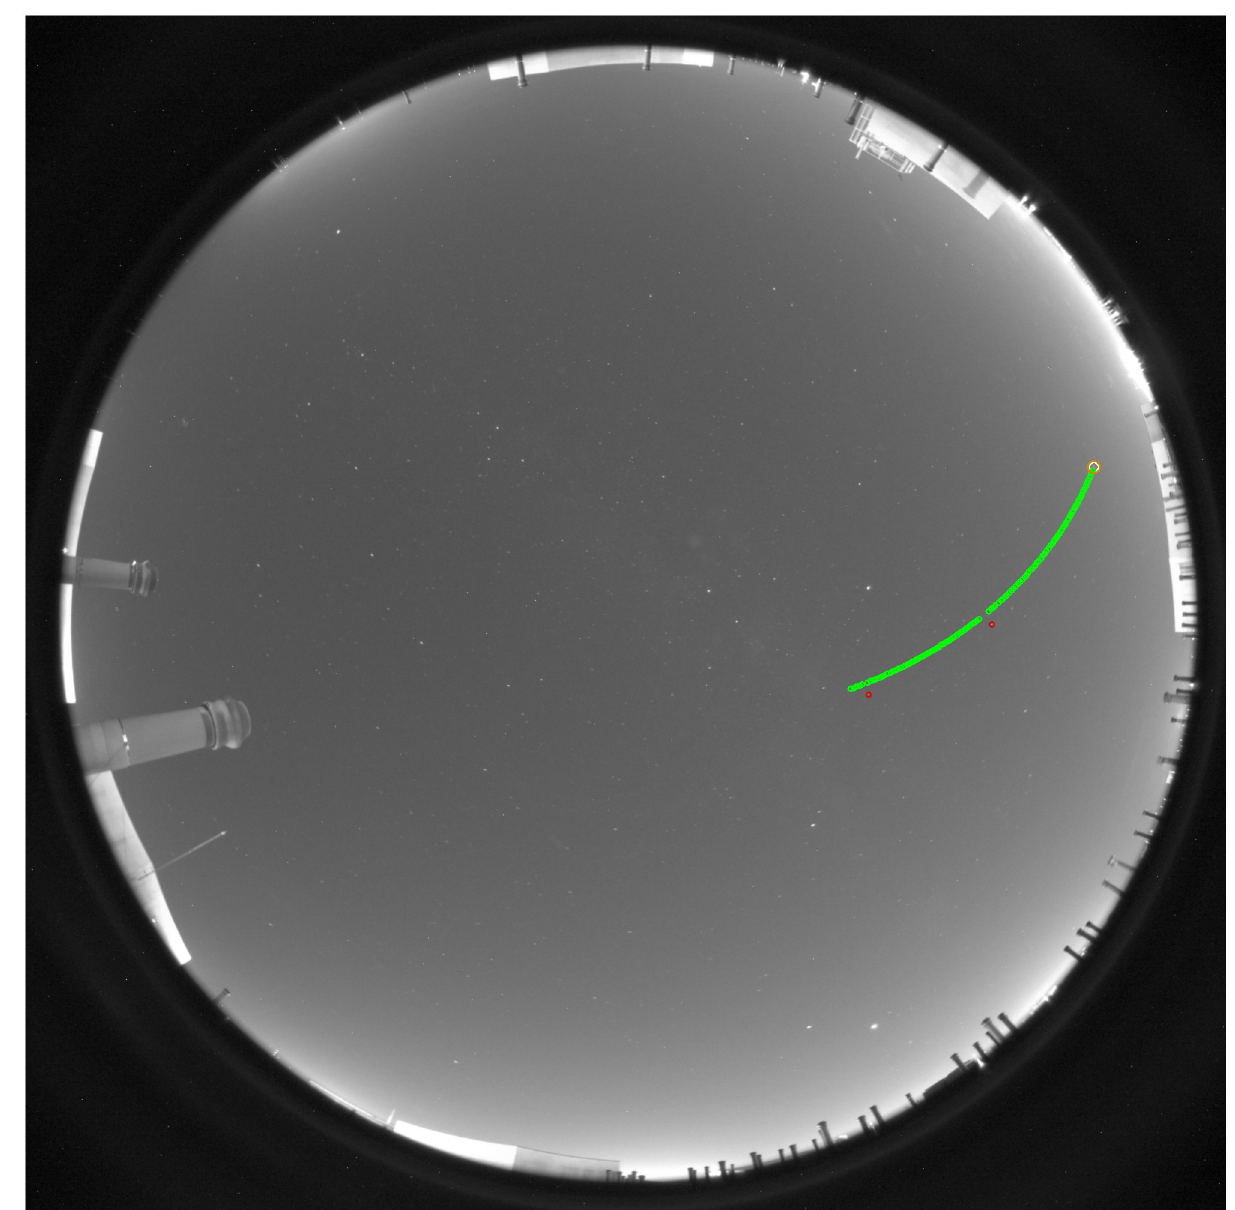
Fig 5. Selected (green dots) and discarded (red dots) points in the image sequence for the Alphecca